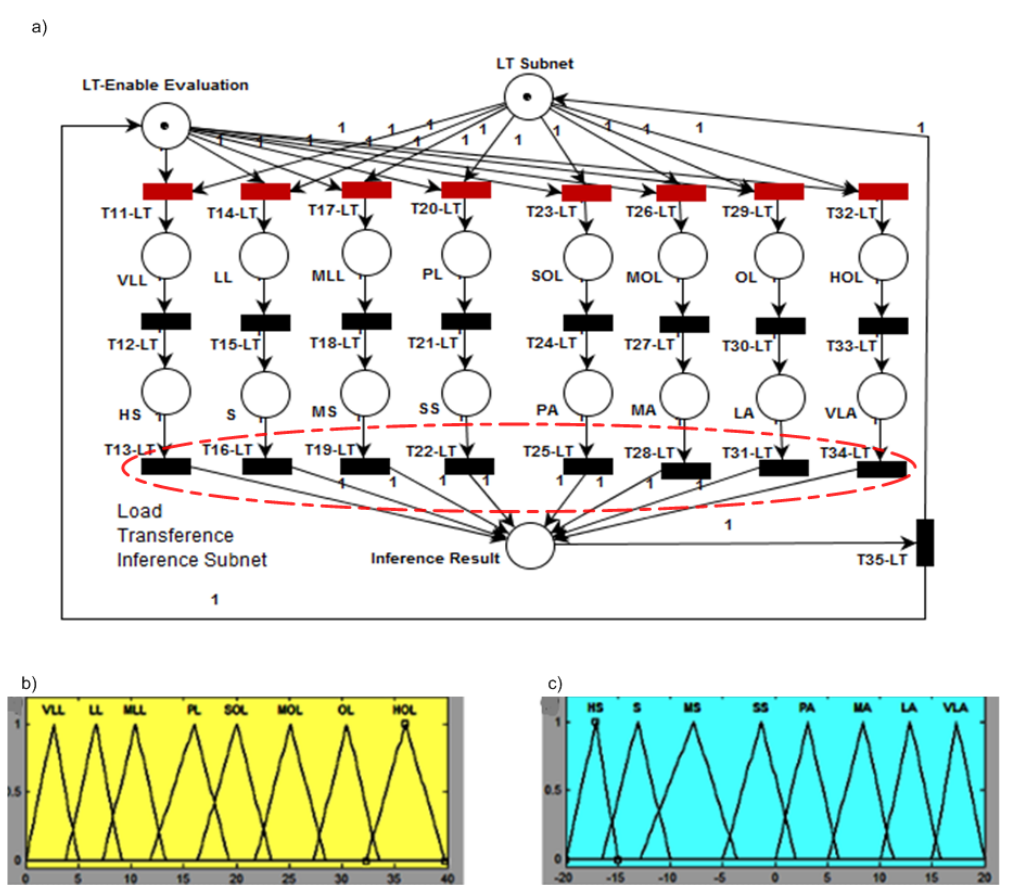
Figure 10. Load Transference subnet: ( a ) LT PN; ( b ) Membership function for input parameters; ( c ) Membership function for output parameters.